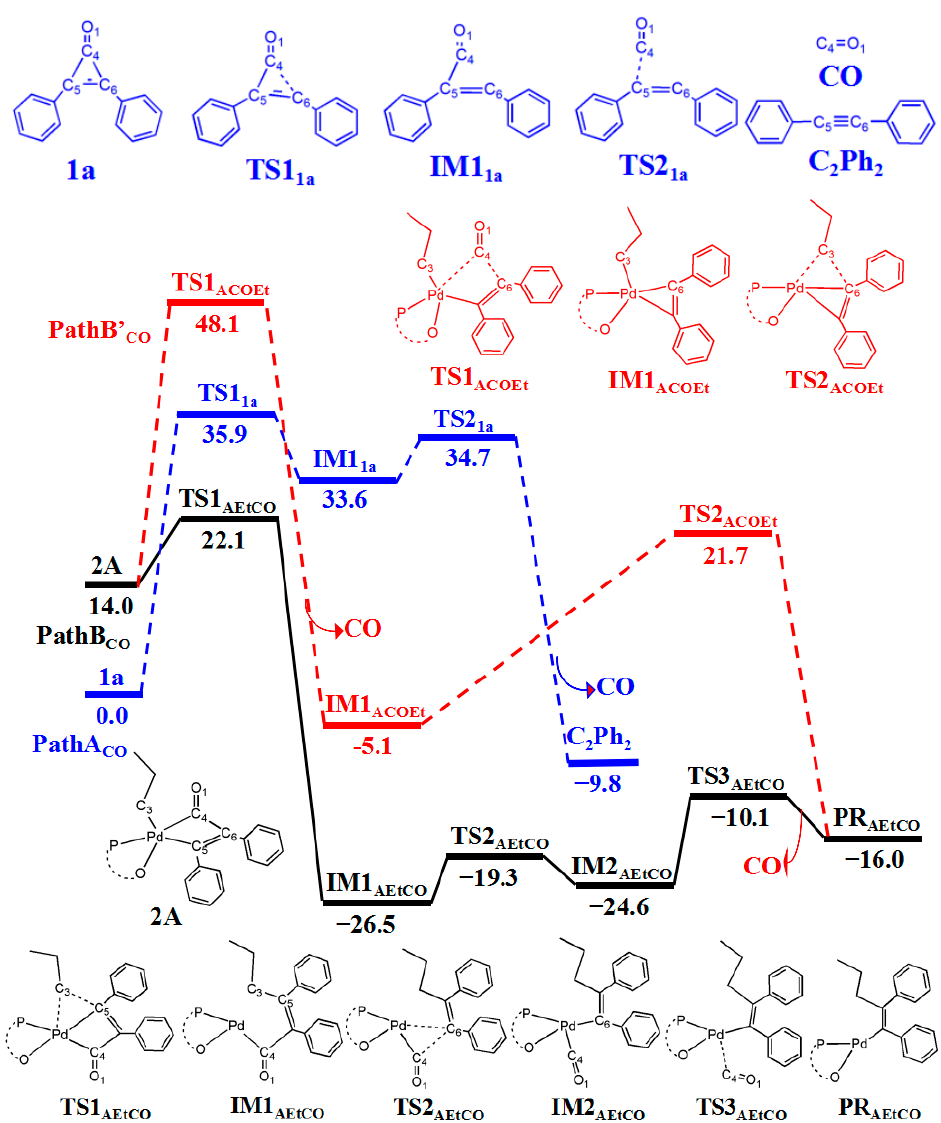
Figure 7. Generation CO from cyclopropenone decomposition reaction pathway without catalyst (Path A CO , blue) or with pd catalyst (Path B CO , black; Path B’ CO , red); the relative free energy is given in kcal/mol.